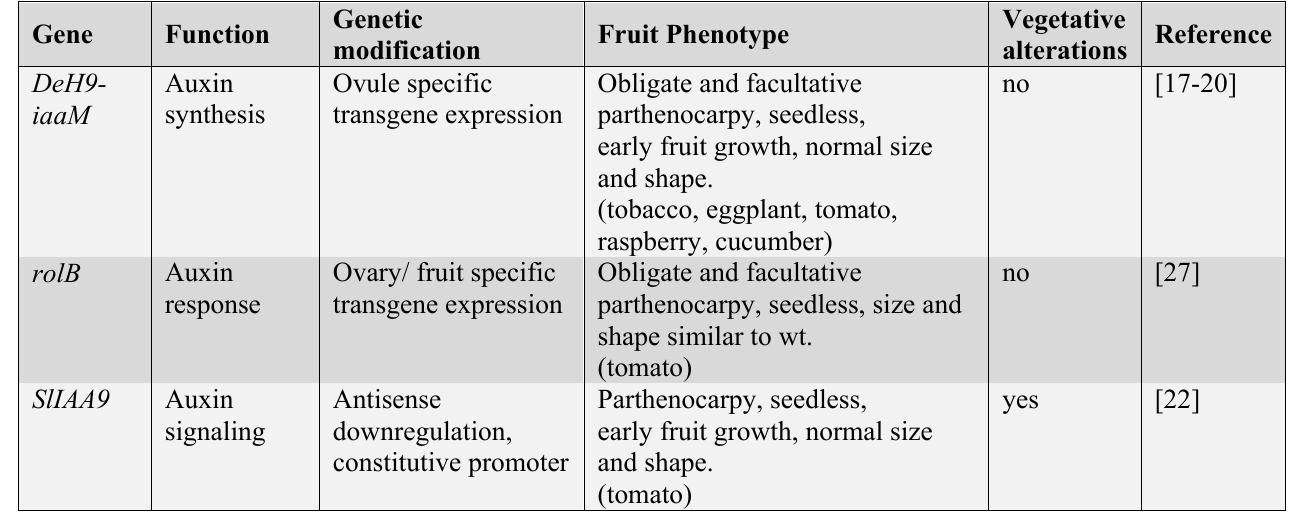
Table 1. Seedless fruit production by genetically engineering hormone-related genes. Sl = Solanum lycopersicum ; At= Arabidopsis